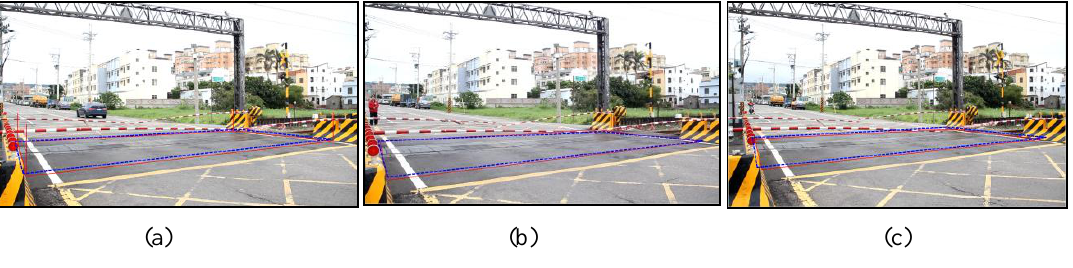
Figure 16. The detection result of the risk area corresponding to case-2, NanSikon Road; the blue-line area is the detection result, and the red-line area is the real measured result: ( a ) the measurement result with the camera mounted in the standard position; ( b ) the measurement result with the camera mounted forward 50 cm; ( c ) the measurement result with the camera mounted 50 cm backward.